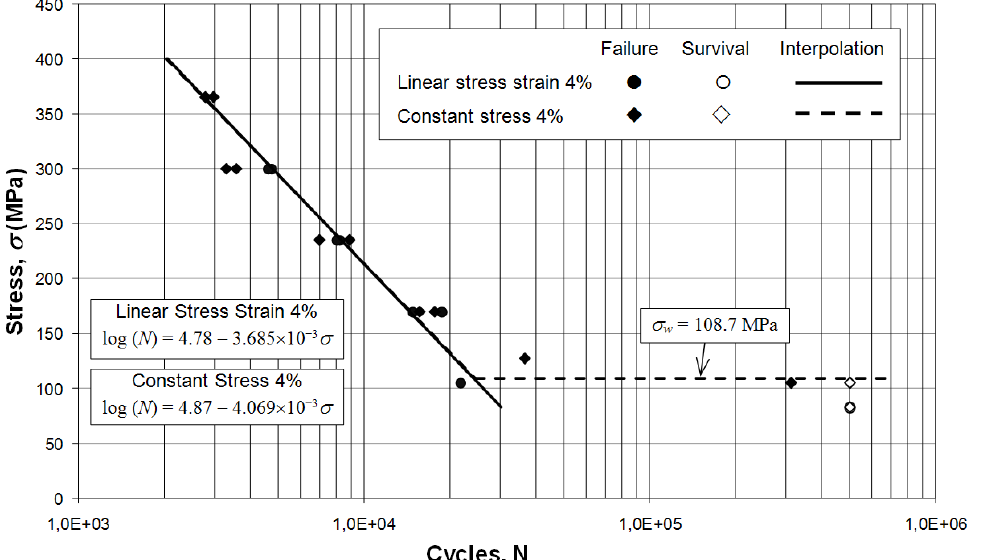
Figure 6: Woehler’s diagram with the fatigue results for the tests under linear stress-strain variation and maximum strain of 4%. Woehler’s curve for the constant stress tests with maximum strain limited to 4% is shown for comparison (dashed